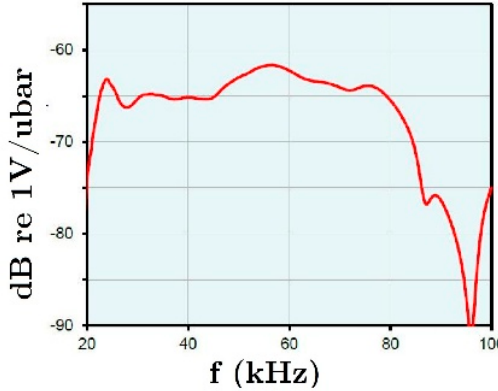
Figure 5. Sensitivity curve of sensor VS30-V. 163